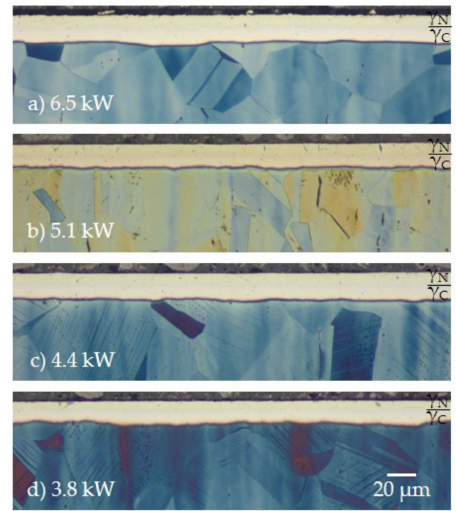
Figure 4. Resulting duplex layer formation for ( a ) 6.5 kW, ( b ) 5.1 kW, ( c ) 4.4 kW, and ( d ) 3.8 kW using a gas composition of N 2 :H 2 = 1:1; T = 733 K; t = 5 h; etchant: Beraha II